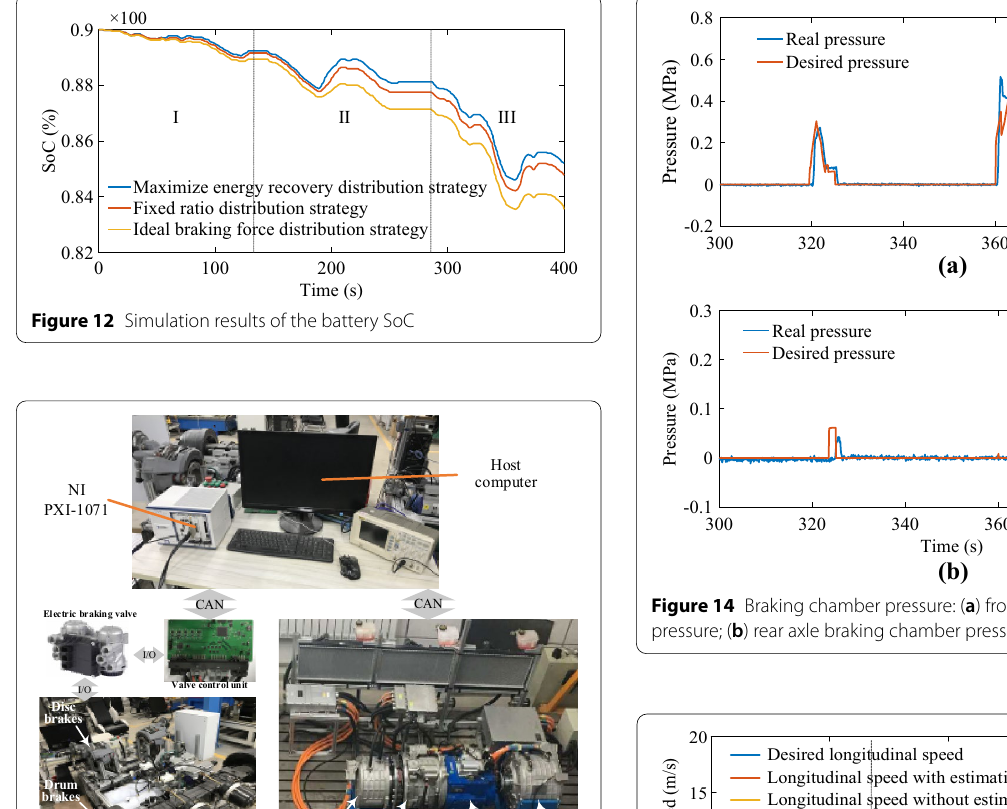
AMTEM for simulating engine Hybrid electric power system